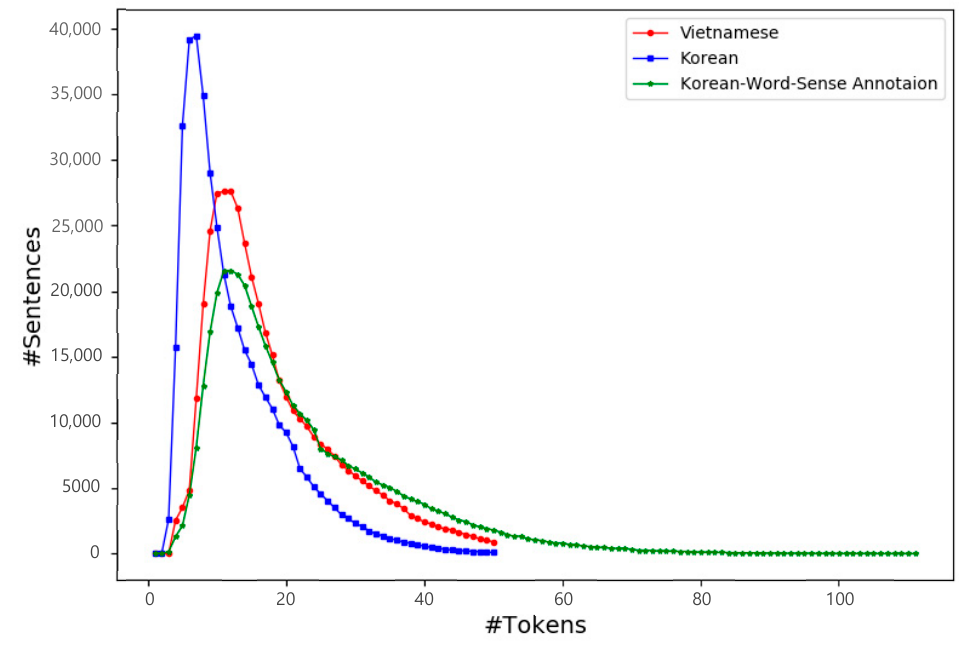
Figure 7. Sentence length distributions of the Korean-Vietnamese parallel corpus.